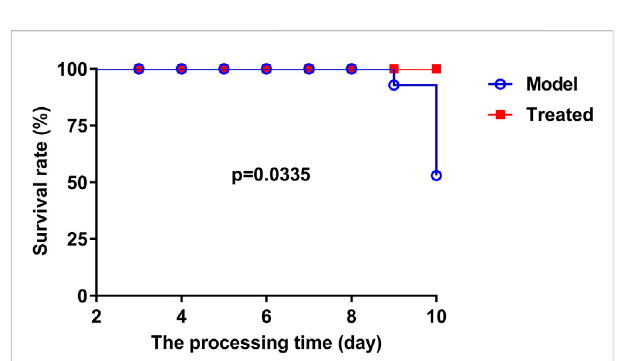
FIGURE 6 The effect of HJ on the survival rate of PEDV-challenged piglets was recorded daily. At 3 days of age, piglets were orally administered HJ or water twice a day. All piglets were orally challenged with 5